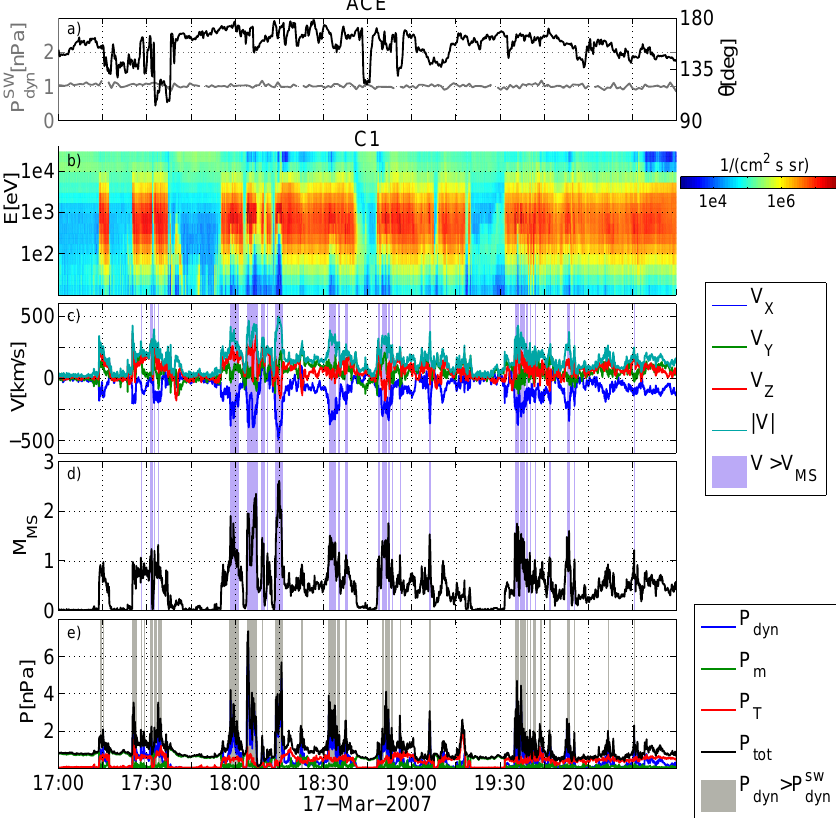
Fig. 6. The uppermost panel: upstream solar wind data from the ACE satellite (time-shifted by 44min). (a) Dynamic pressure of the solar wind and the angle θ between the magnetic field direction vector and the X GSE -axis. Lower panels: Cluster C1 observations of jets and pressure pulses in the magnetosheath. (b) Omni-directional ion energy spectrograms. (c) Ion velocity measurements in the GSE coordinates. The intervals when the total plasma speed was larger than the local magnetosonic speed are shaded in blue. (d) Magnetosonic Mach number V/V MS . (e) The dynamic pressure, the magnetic pressure, and the thermal pressure of the plasma, as well as the total pressure. The intervals when the dynamic pressure exceeded the solar wind dynamic pressure (1nPa) are shaded in grey. Panel (a) is adapted from Hietala et al. (2009).